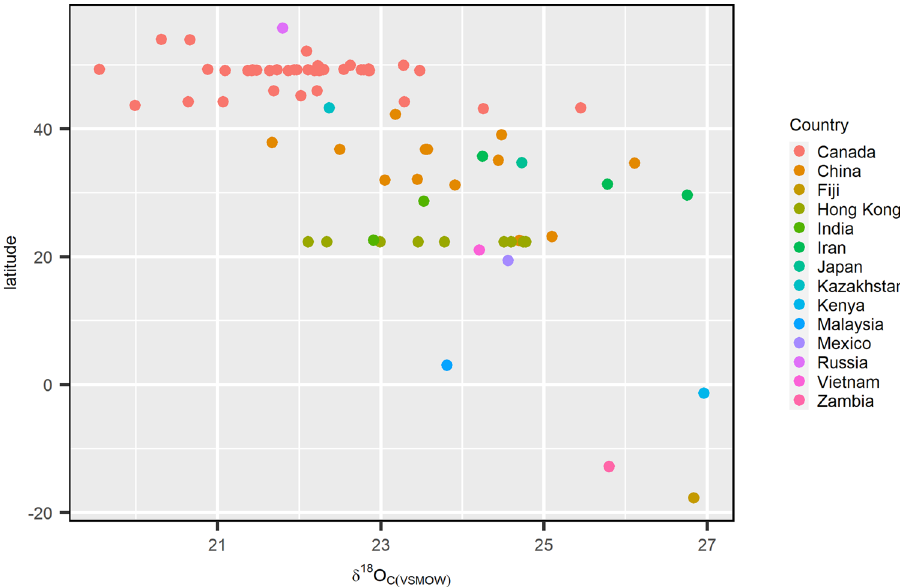
Figure 9. A plot of latitude vs δ 18 O c(VSMOW) of all data (n = 75). A general latitudinal trend can be observed with δ 18 O c values increasing decreasing latitude.